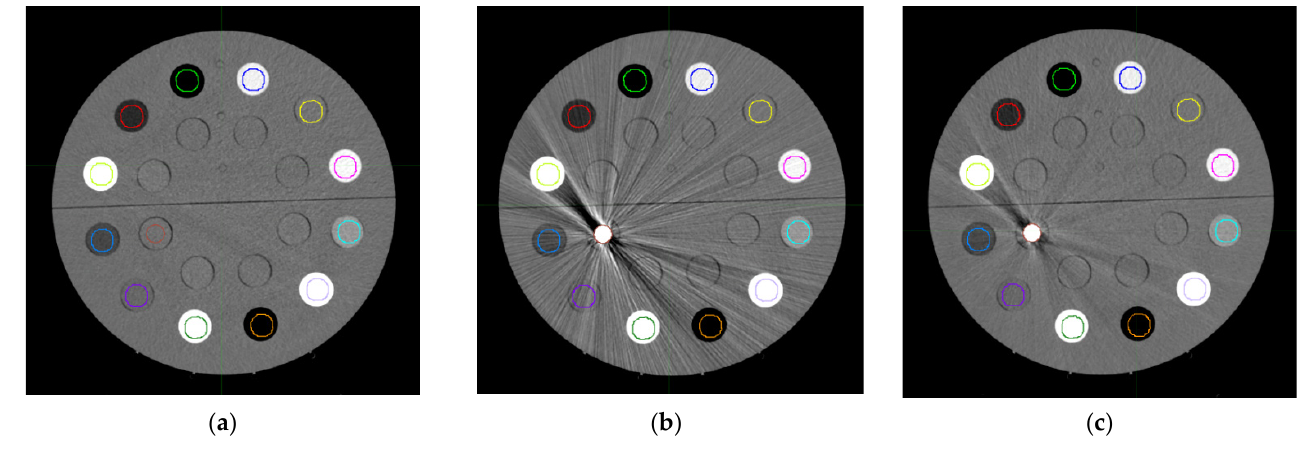
Figure 1. The CT scans of the Cheese phantom reconstructed with the standard algorithm Qr40, acquired at 120 kVp: ( a ) without metal inserts; ( b ) with the stainless ‐ steel insert with a nominal density of 8 g/cm 3 ; ( c ) with the titanium insert with a nominal density of 4.51 g/cm 3 .